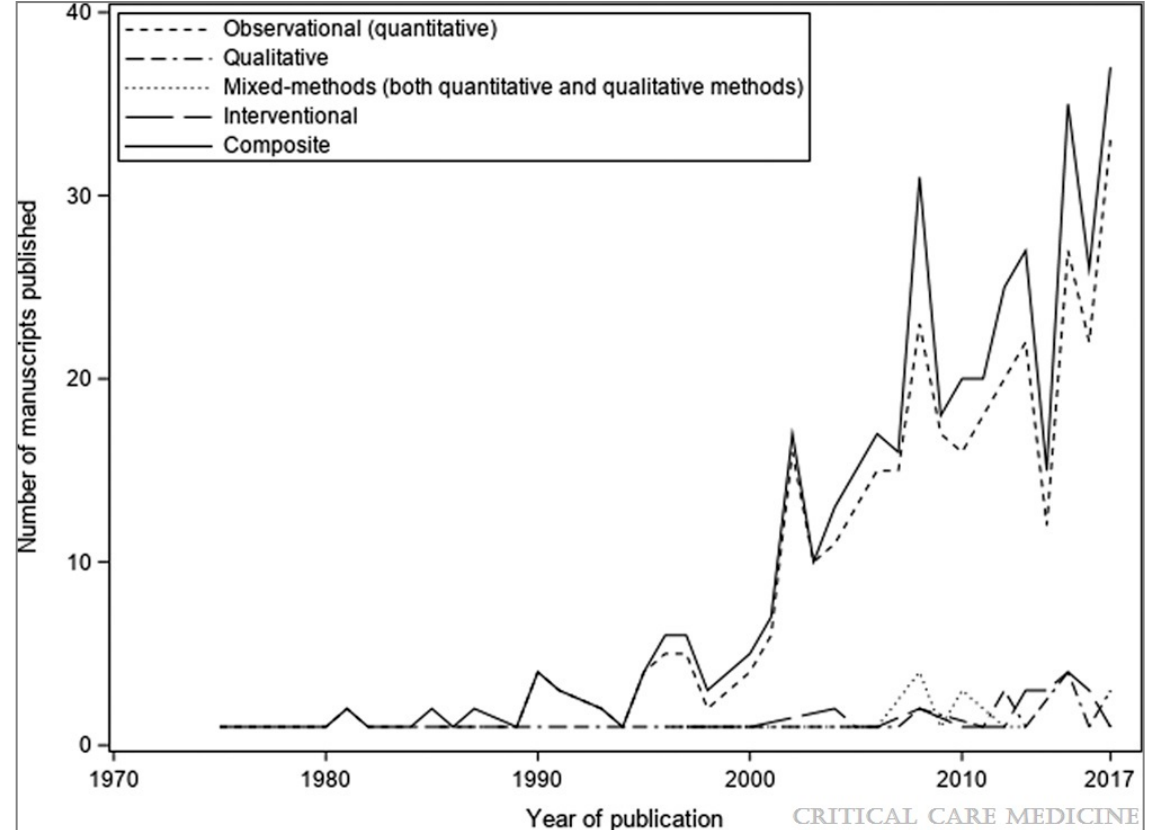
Figure 1. Number of manuscripts evaluating post-discharge outcomes after pediatric critical illness and study designs. Composite in the legend refers to the additive total number of articles. Original figure by Maddux et al. [20]. Graph generated using a comprehensive search strategy outlined in Table S2 of the Supplemental Digital Content in the original article, title and abstract exclusion, and dual full-text screening of the remaining articles [20]. Reprinted with appropriate permission from Wolters Kluwer. Original Copyright © 2021 by the Society of Critical Care Medicine and the World Federation of Pediatric Intensive and Critical Care Societies.